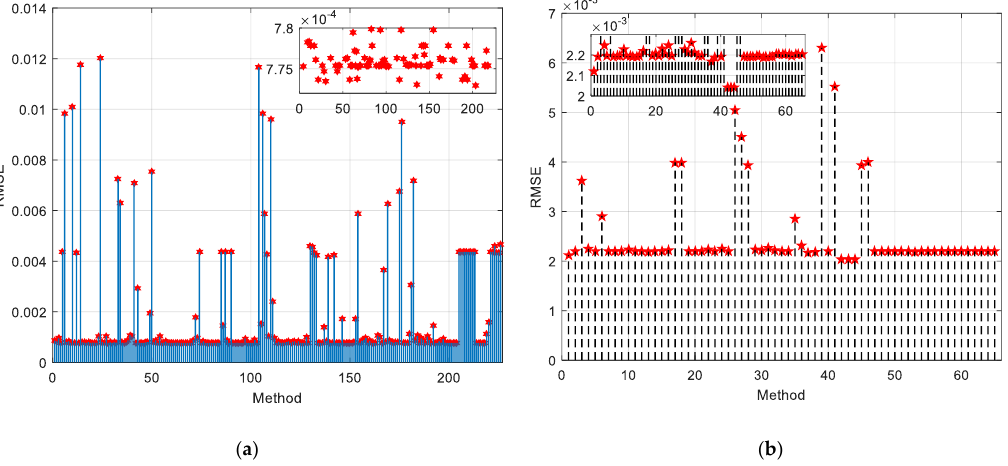
Figure 2. RMSE calculated for: ( a ) RTC France solar cell; ( b ) Photowatt-PWP201 module.